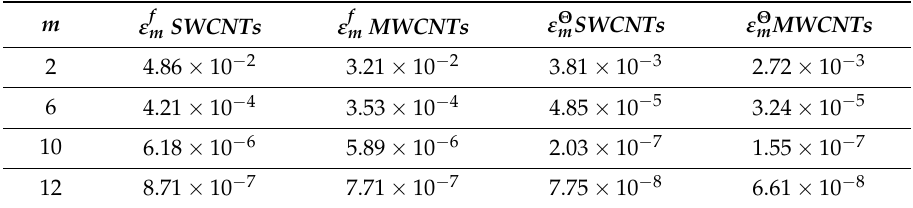
Table 2. Individual averaged squared residual errors for SWCNTs/MWCNTs-Water when β =